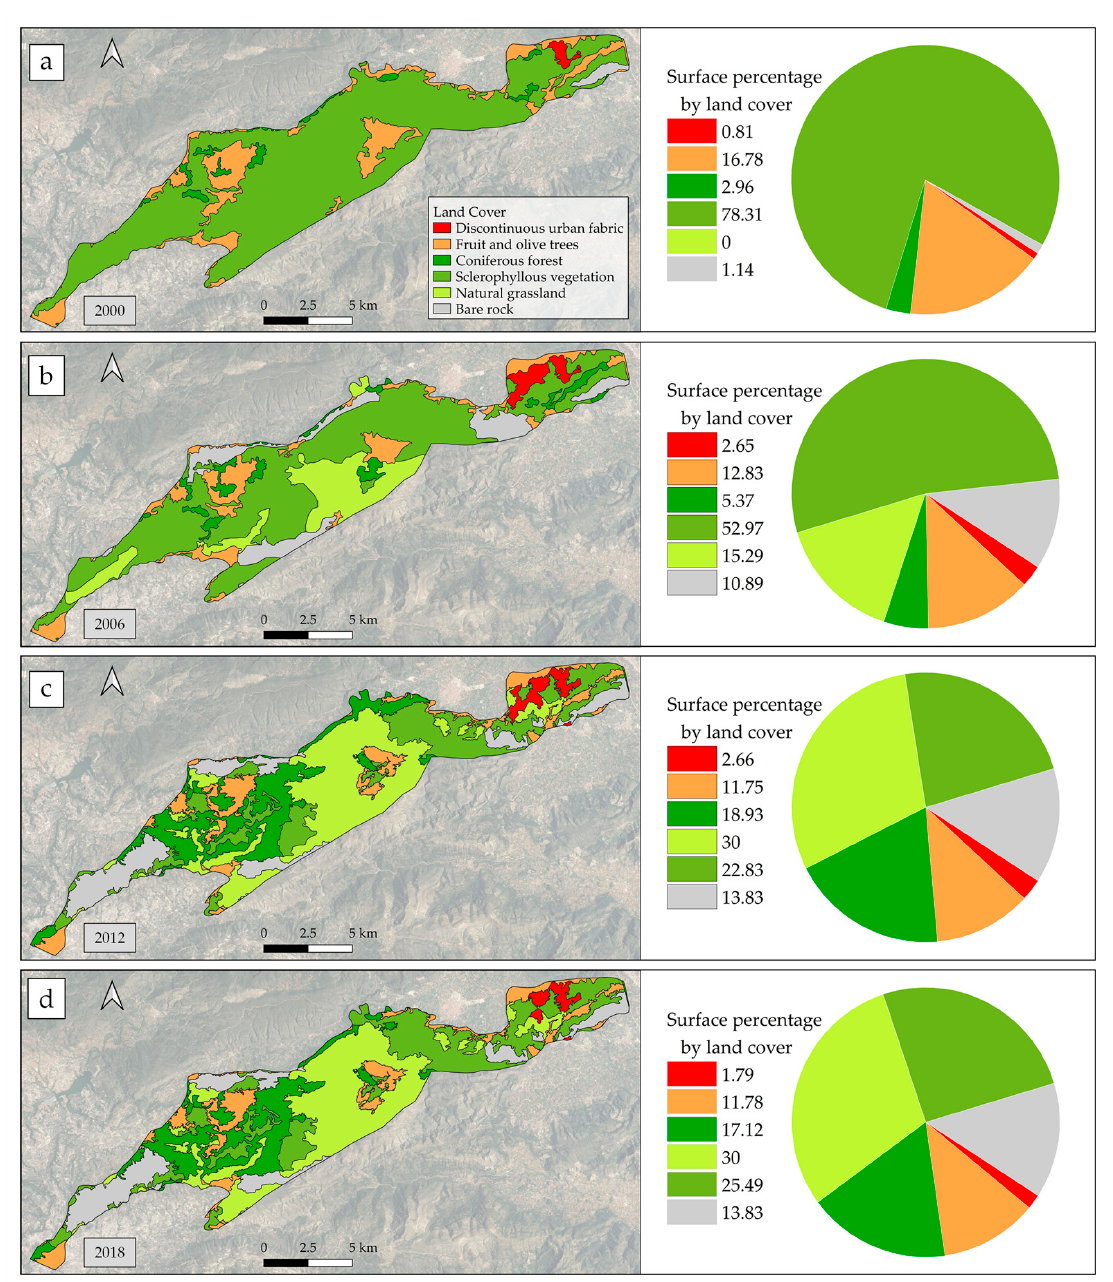
Figure 2. Spatial distribution of the actual scenario: historic land covers and the corresponding surface percentage for: ( a ) year 2000; ( b ) year 2006; ( c ) year 2012; and ( d ) year 2018.